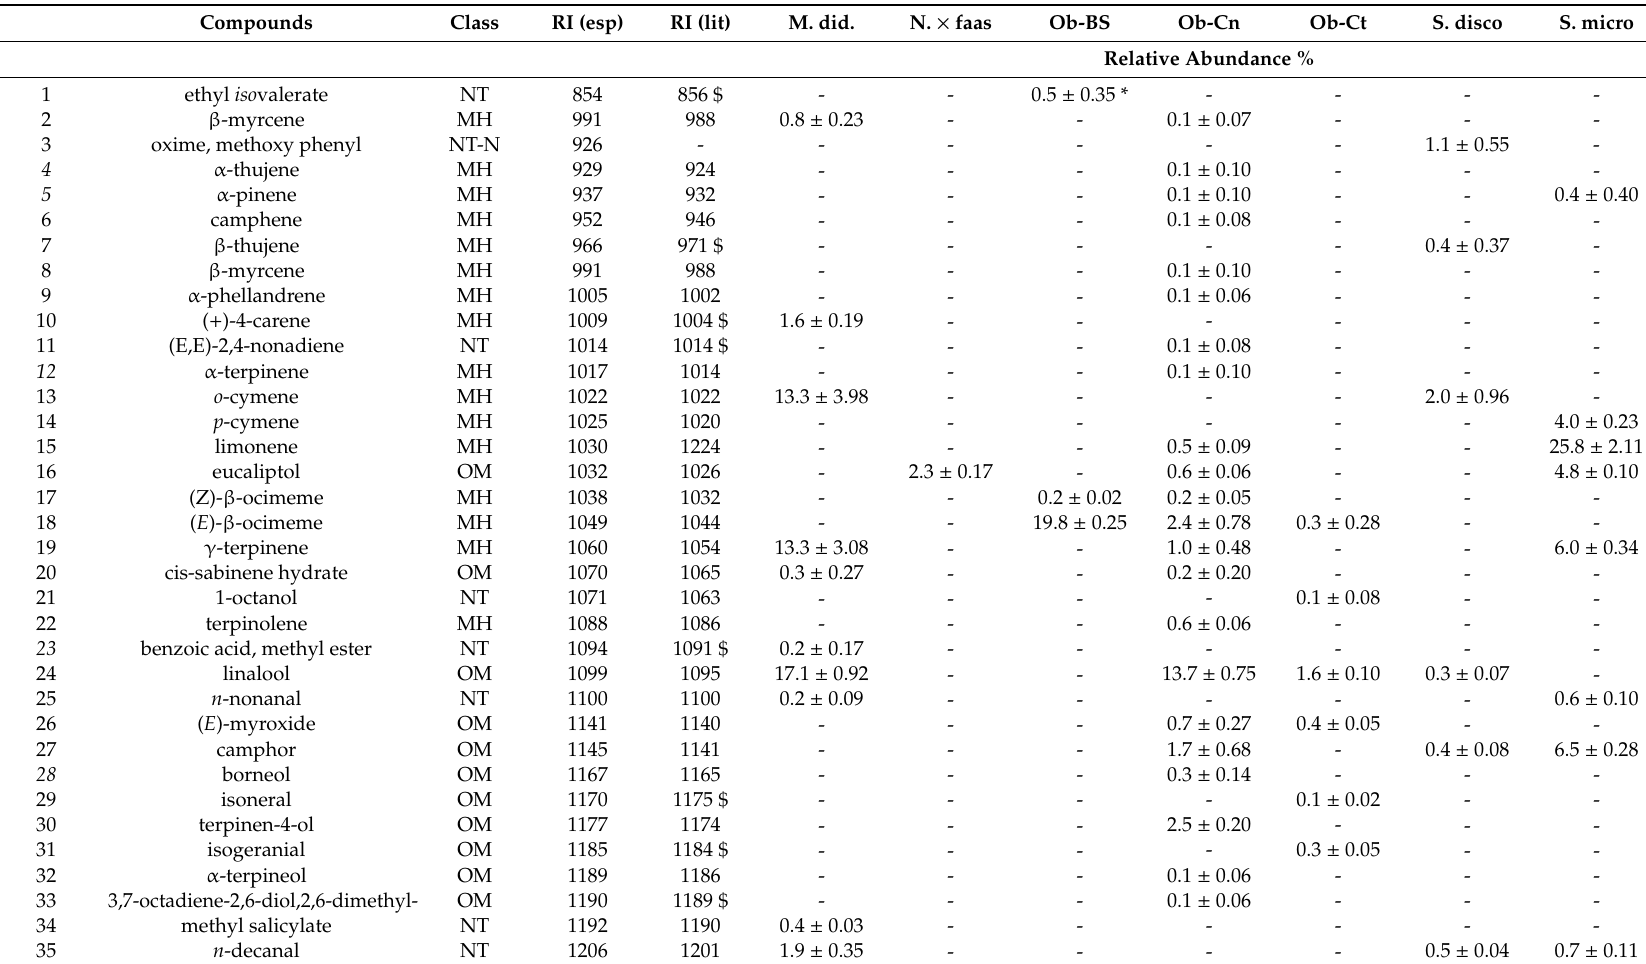
Table 3. Volatile chemical composition (by headspace solid phase microextraction, HS-SPME) of flowers from the studied Lamiaceae species (n = 3) 1 .